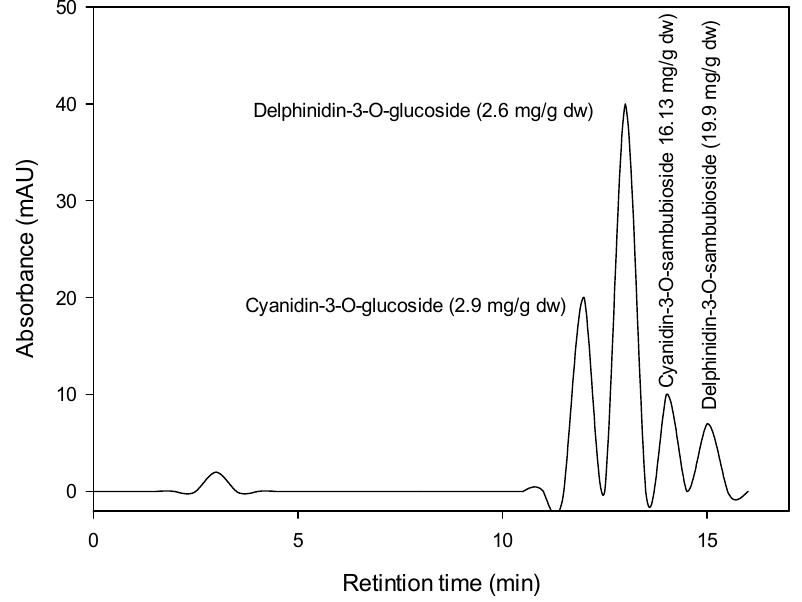
Figure 1. HPLC chromatogram of Hibiscus anthocyanins at 521 nm.